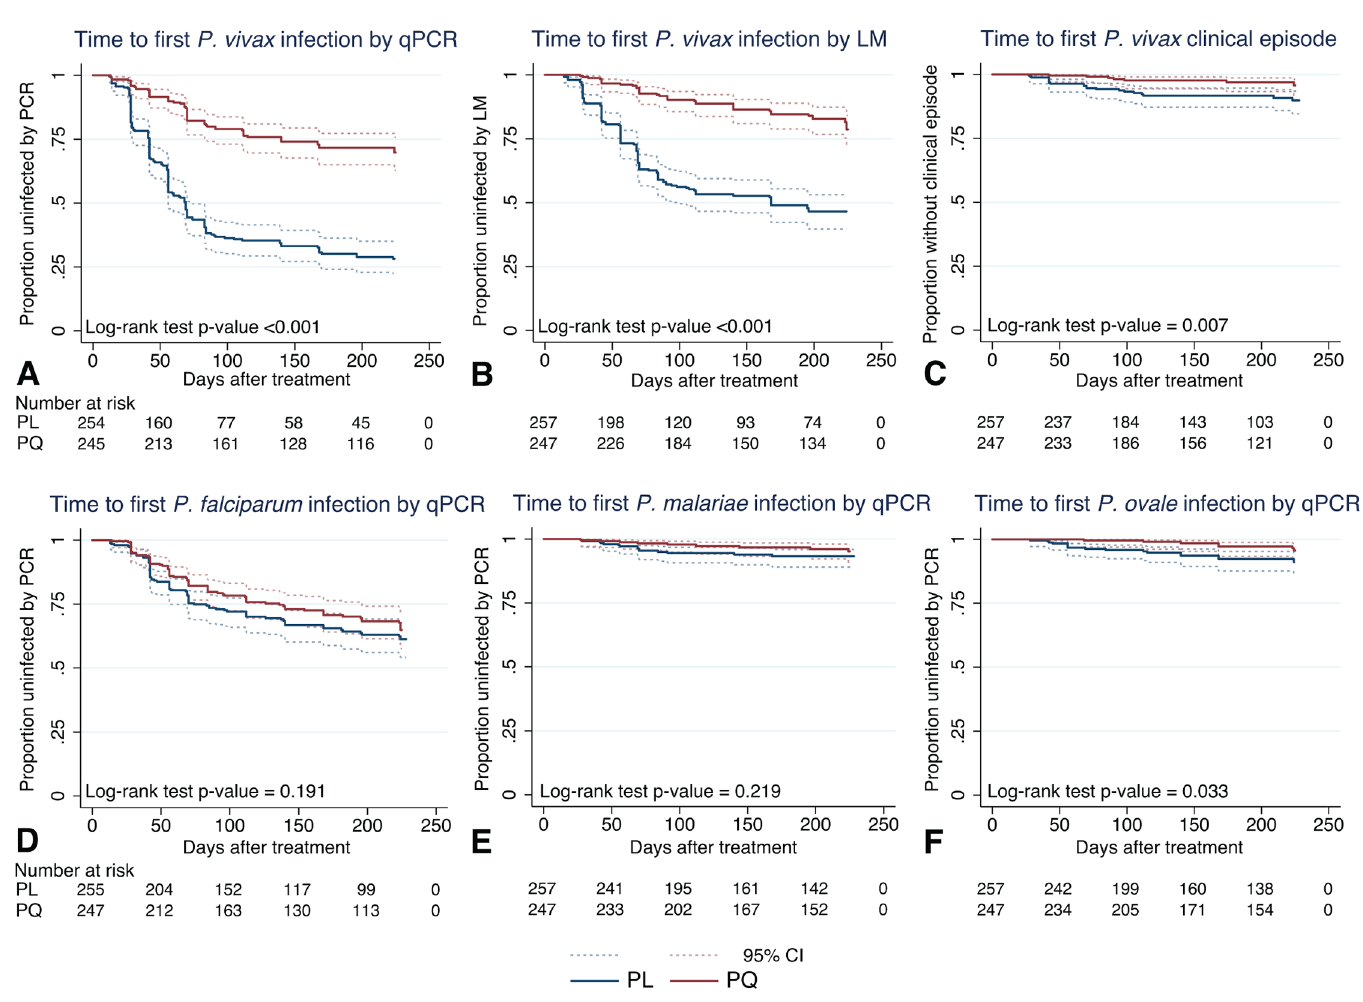
Fig 4. Time to first Plasmodium spp. infection and P . vivax clinical episode. Kaplan-Meier plots showing the time to first (or only) (A) P . vivax infection by qPCR, (B) P . vivax infection by LM, (C) P . vivax clinical episode, (D) P . falciparum infection by qPCR, (E) P . malariae infection by qPCR, and (F) P . ovale infection by qPCR, in the two treatment arms. Dashed lines represent the respective 95% confidence